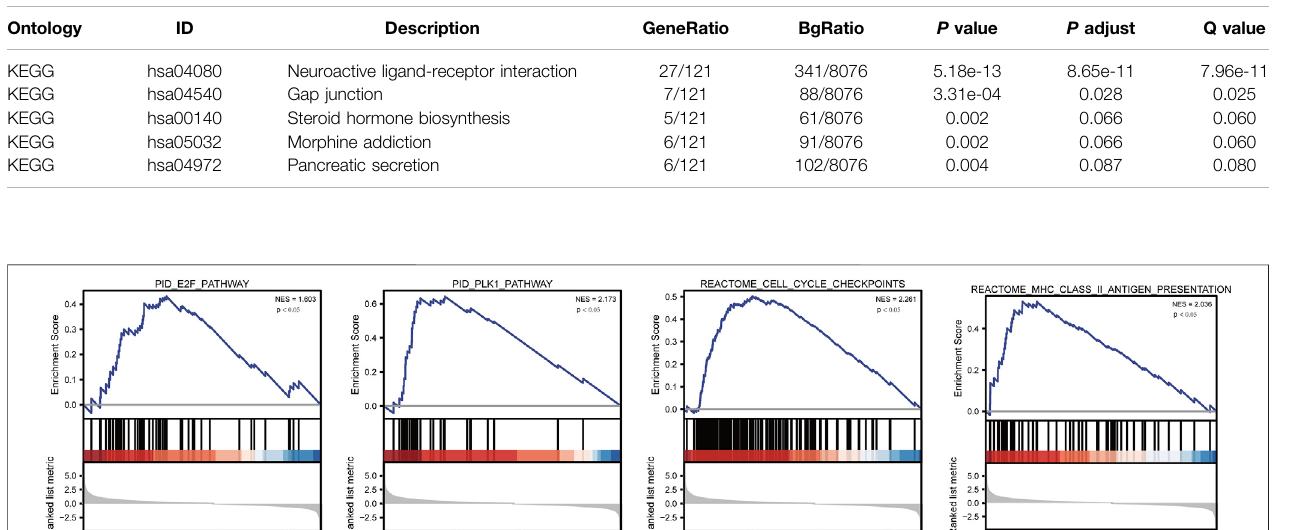
TABLE 2 | KEGG analysis.